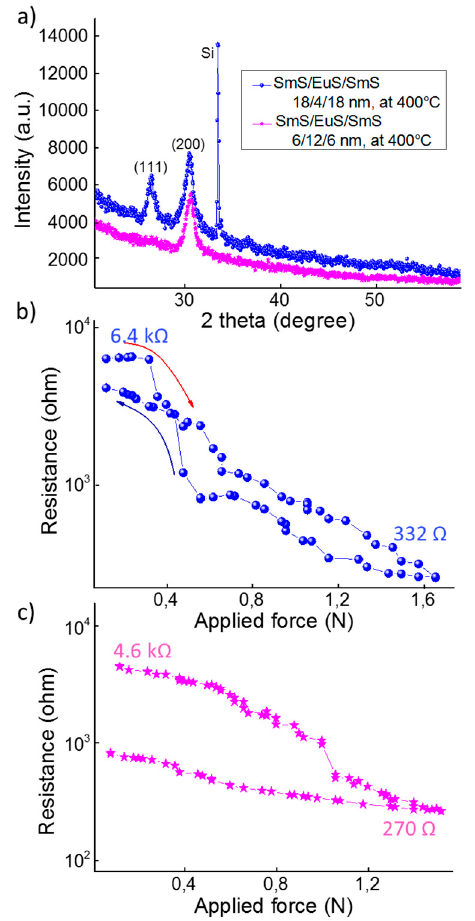
Figure 8. ( a ) XRD patterns of the thinner tri-layer systems (18 / 4 / 18 nm in blue dots and 6 / 12 / 6 nm in purple stars). Piezoresistance behavior for 18 / 4 / 18 nm tri-layer ( b ) and 6 / 12 / 6 nm tri-layer ( c ) deposited in between Ir electrodes. For clarity, in ( b ) red arrow represents the loading process, while the navy arrow shows the unloading process.